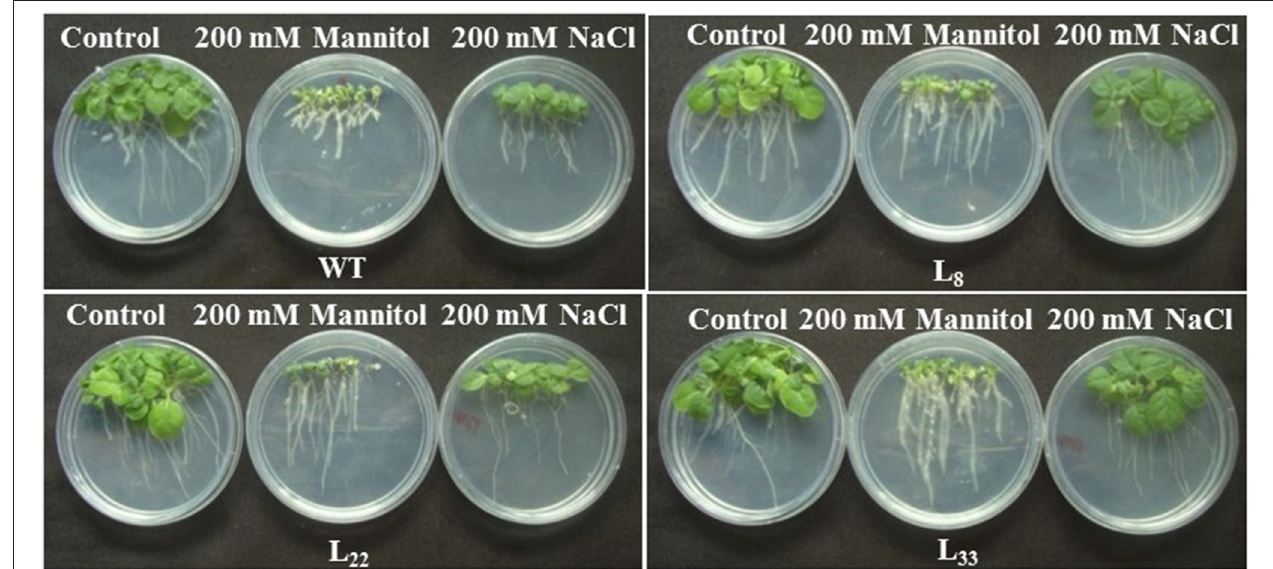
FIGURE 3 | Growth responses of WT and transgenic (L 8 , L 22 , and L 33 ) tobacco under drought (200mM mannitol) and salt (200 mM NaCl) stress conditions for 21 days.